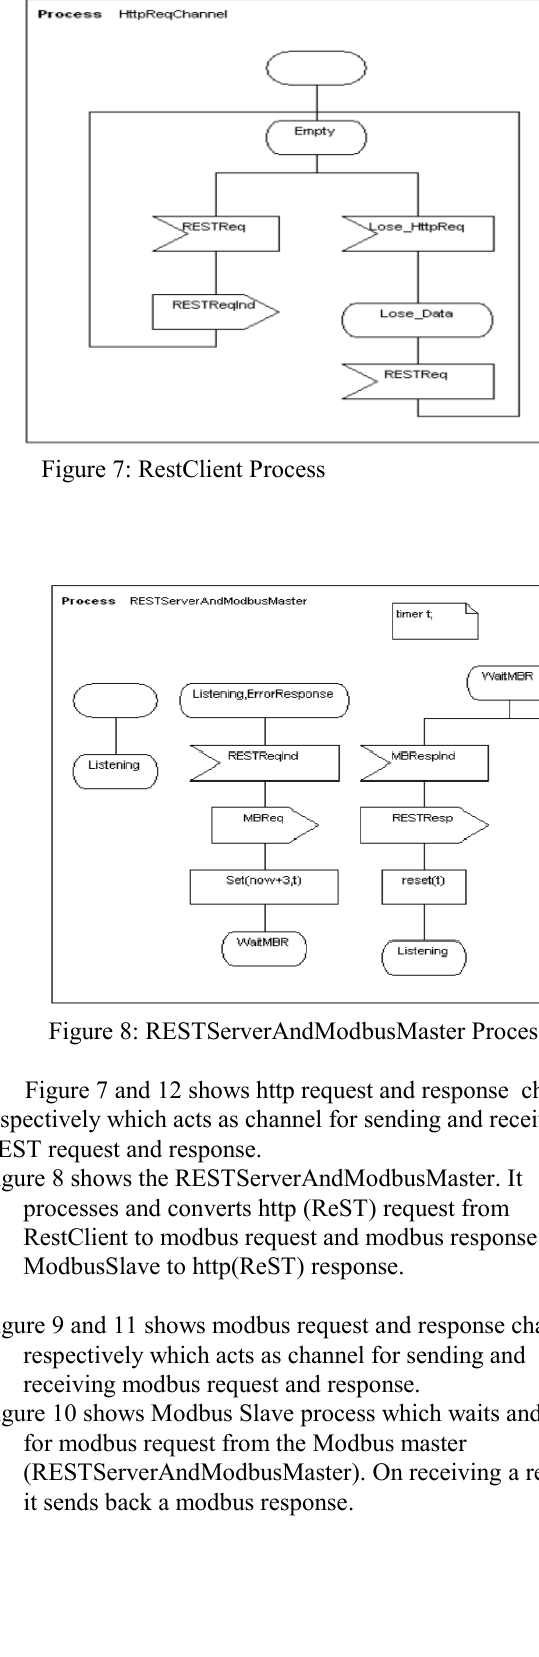
Figure 6 : RestClient process specification